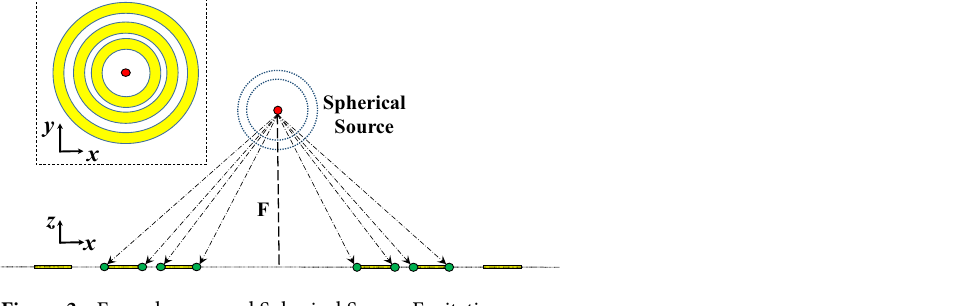
Figure 3. Fresnel zones and Spherical Source